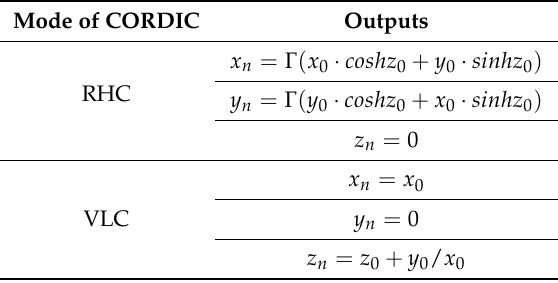
Table 1. Outputs of RHC and